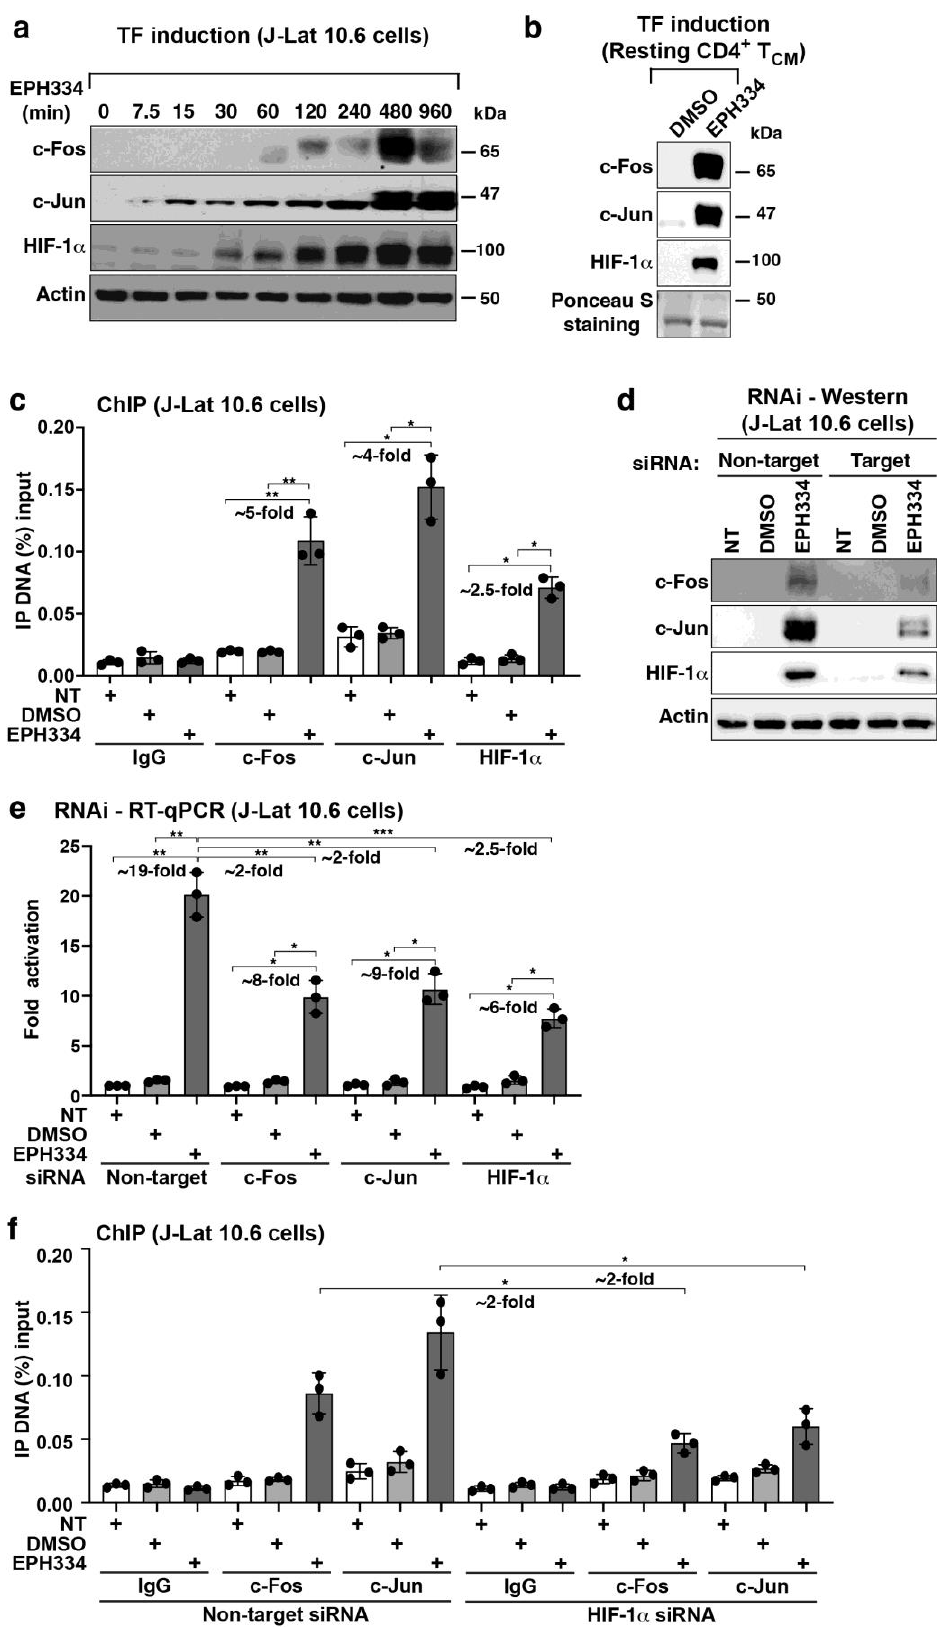
Figure 5. EPH334 induces redox-sensitive transcription factors that directly activate the HIV-1 proviral genome. ( a ) Western blots of J-Lat 10.6 cells showing EPH334-mediated temporal induction of c-Fos, c-Jun, and HIF-1 α . ( b ) Western blots of primary resting CD4 + T central memory (T CM ) cells